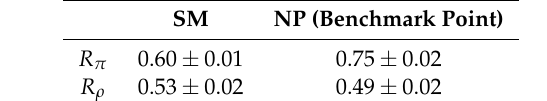
Table 1. R π and R ρ in Equation (14) in SM and in NP at the benchmark point.